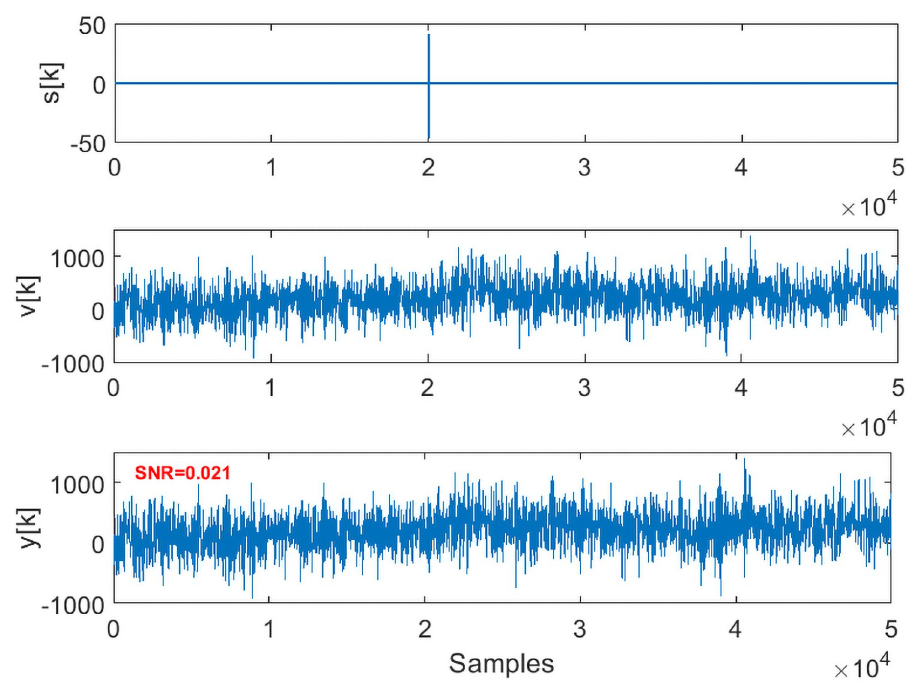
Fig 3. Low SNR synthetic data with a short-lived event embedded in